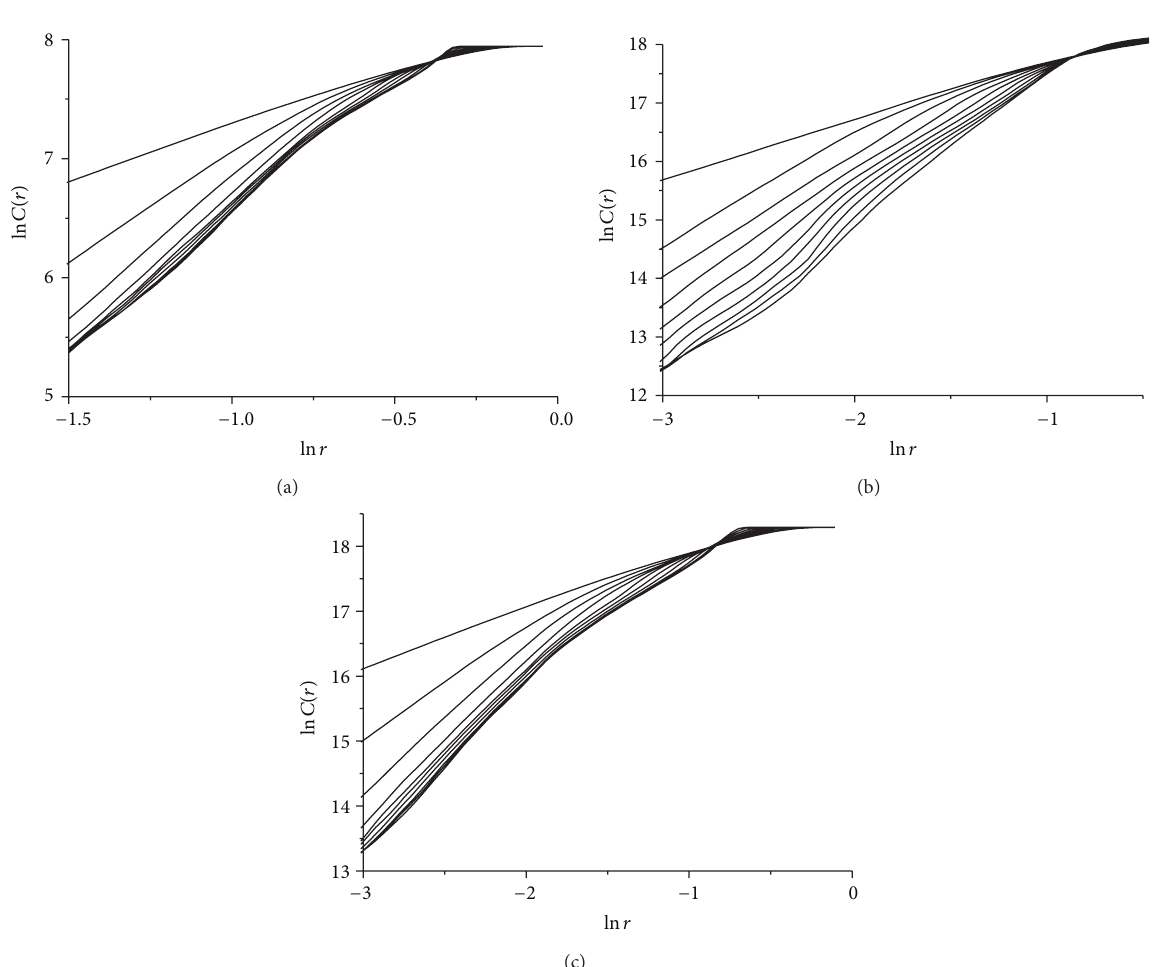
Figure 7: Relation between ln 𝐶(𝑟) and ln 𝑟 for different embedding dimensions 𝑚 for roll angle 𝛼 time-series for (a) wax, (b)gypsum, and (c) lead-solder, materials.